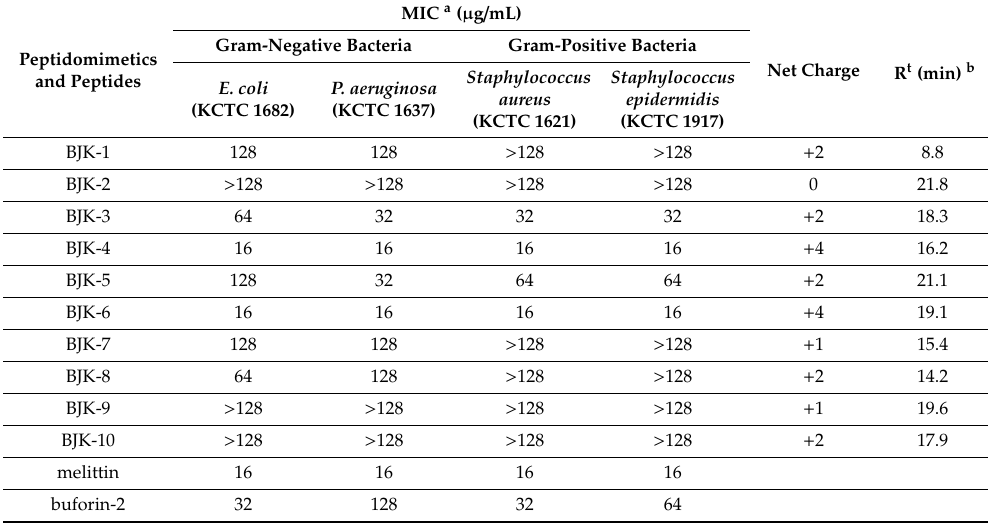
Table 1. Antimicrobial activity of the designed peptidomimetics, buforin-2 and melittin.